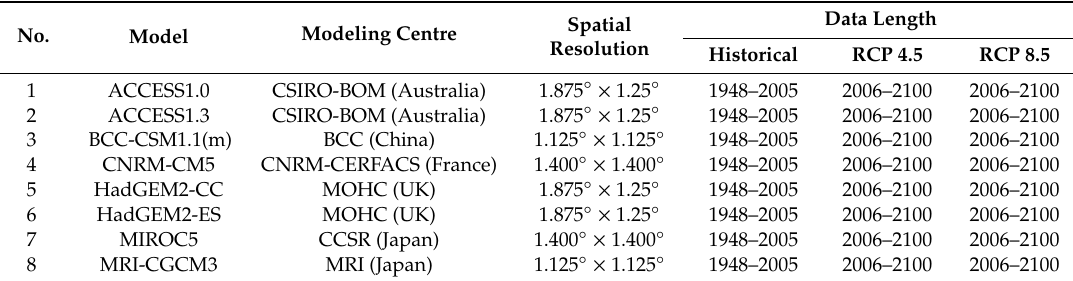
Table 2. The Coupled Model Inter-comparison Project Phase-5 (CMIP5) model attributes selected in this